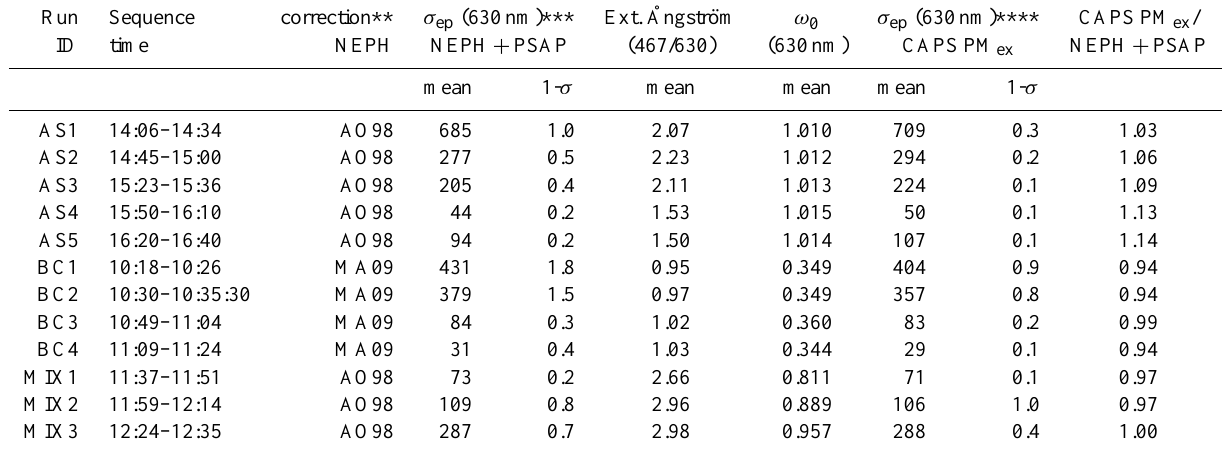
Table 3. Data used for the evaluation of CAPS PM ex with laboratory-generated polydisperse test aerosols: AS, BC, and mixed AS + BC*.